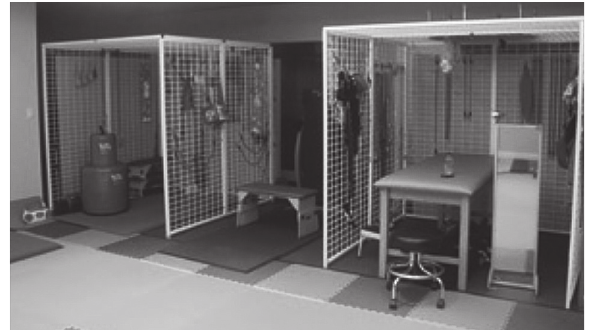
Figure 2 - Ability exercise unit (spider and monkey cage) Source: Research